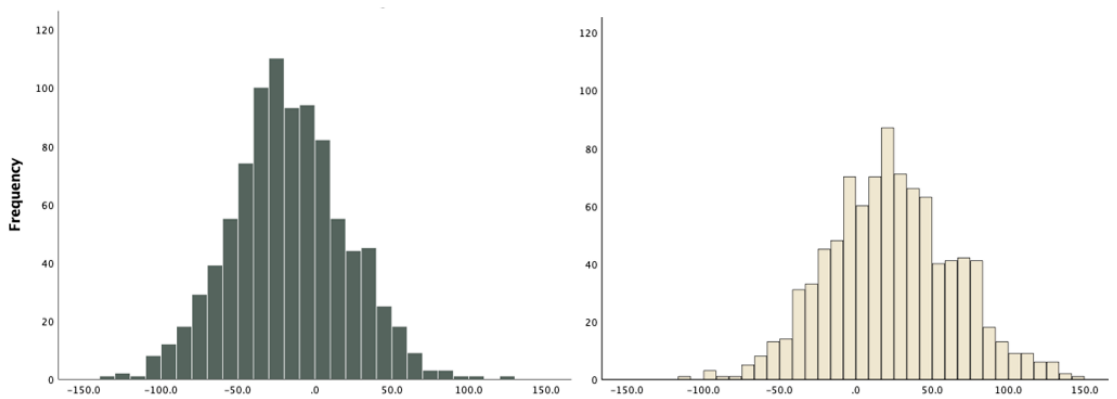
Figure 2. Histograms showing normal distributions of HBI in children (5–17 years old; left) and parents (right).